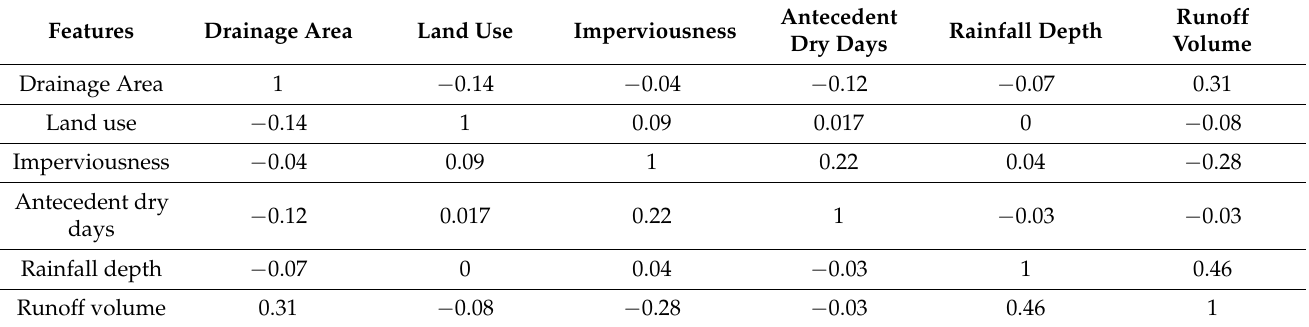
Table 2. Correlation